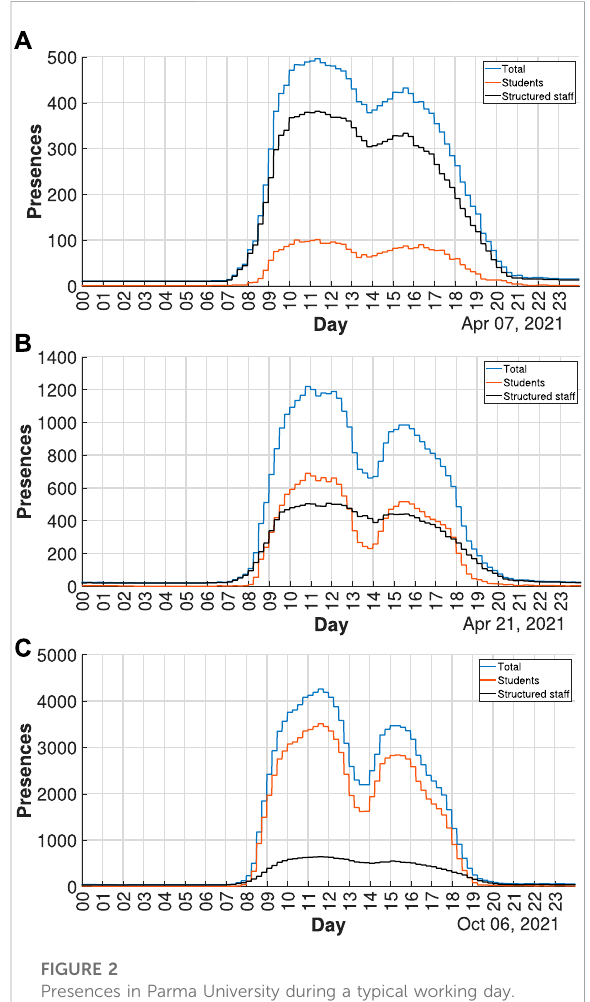
Presences in Parma University during a typical working day. (A) Time evolution of attendance during a typical working day in the closing regime. In this phase, staff members provide the larger contribution, and the presence of students is very limited. In (B), we see that students and structured staff provide a similar contribution, while in (C), we notice that in the total opening phase, the dynamical behavior is completely driven by the student